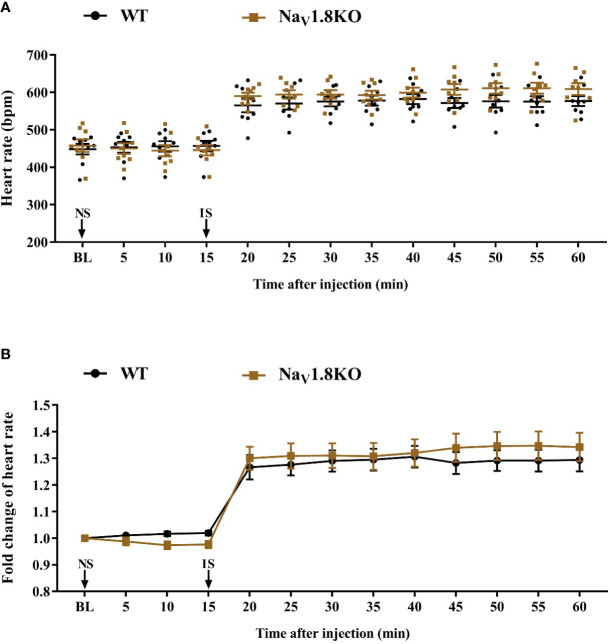
The heart rate response of isoprenaline in NaV1.8 knockout mice. (A) Scatter diagram of heart rate after isoprenaline application. (B) Line diagram of fold change of heart rate after isoprenaline treatment. Heart rate was normalized to the value of baseline heart rate for each group. WT, wild type; KO, knock out; NS, normal saline; IS, isoprenaline; BL, baseline.